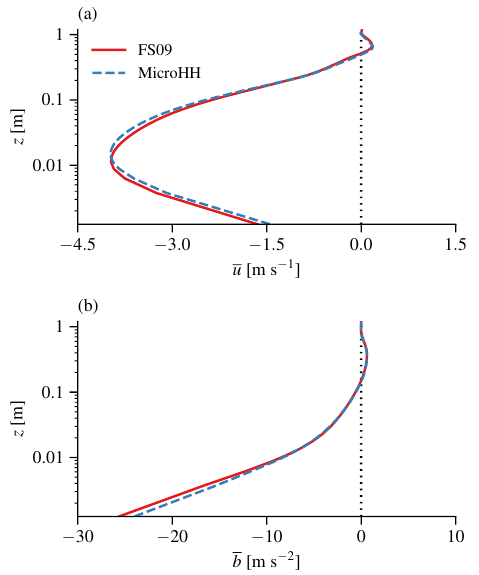
Figure 8. Profile of the mean along-slope velocity (a) and buoy- ancy (b) as predicted by MicroHH and FS09.